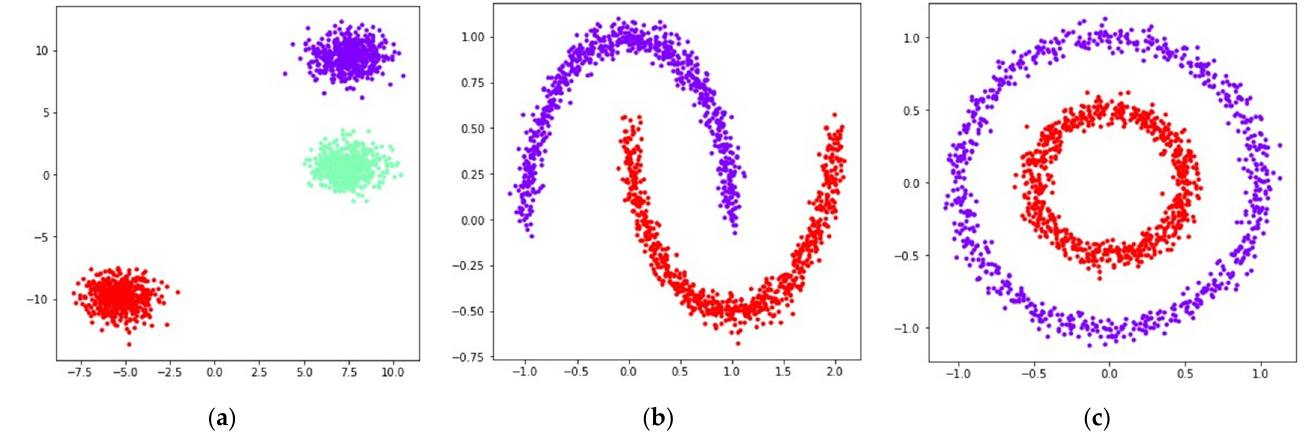
Figure 1. Locations of 1500 points belonging to the datasets generated by sklearn [29] in ℝ (cid:2870) : ( a ) blobs; ( b ) moons, noise level is set to 0.05; ( c ) circles, noise level is set to 0.05, inner circle radius is equal to one half of the outer circle radius.